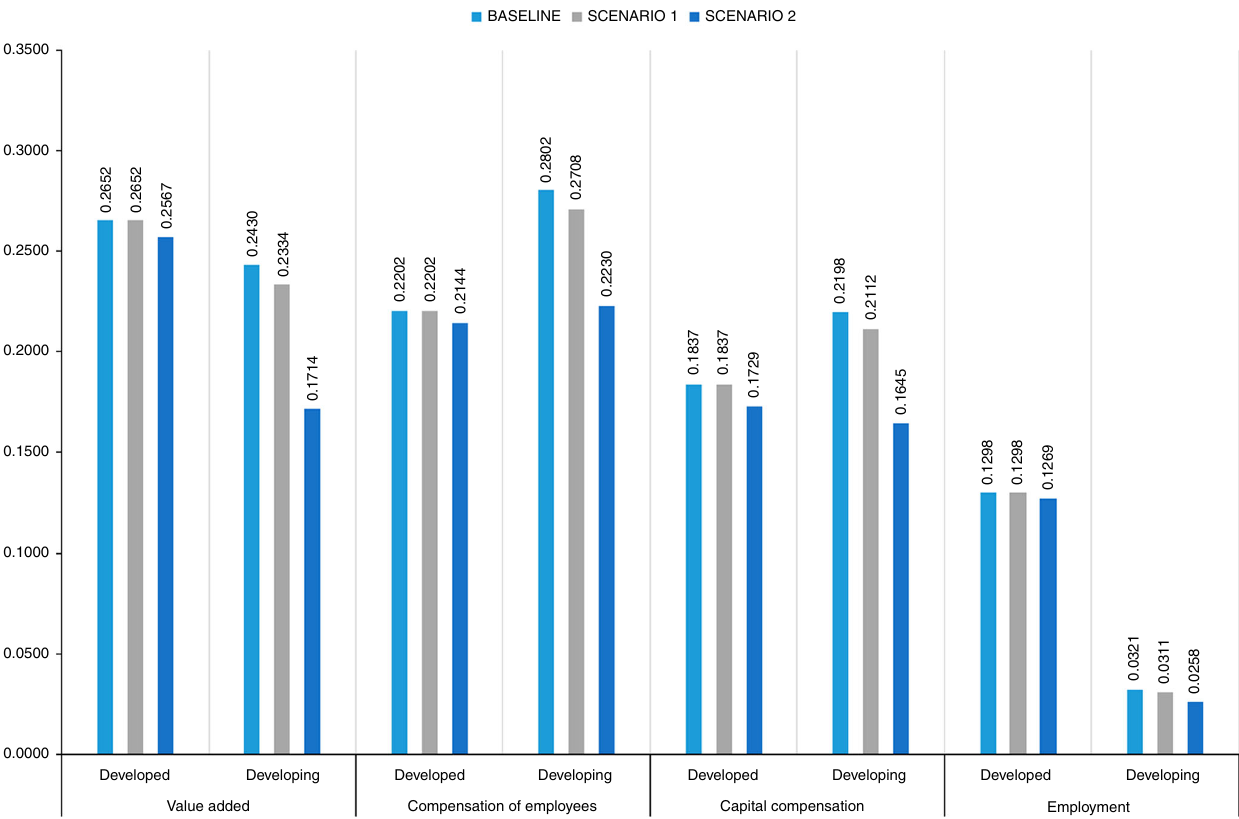
Fig. 7 2009 US-MNEs ’ carbon footprint in developed and developing countries by indicator and scenario (GtCO 2 ) See Supplementary Data